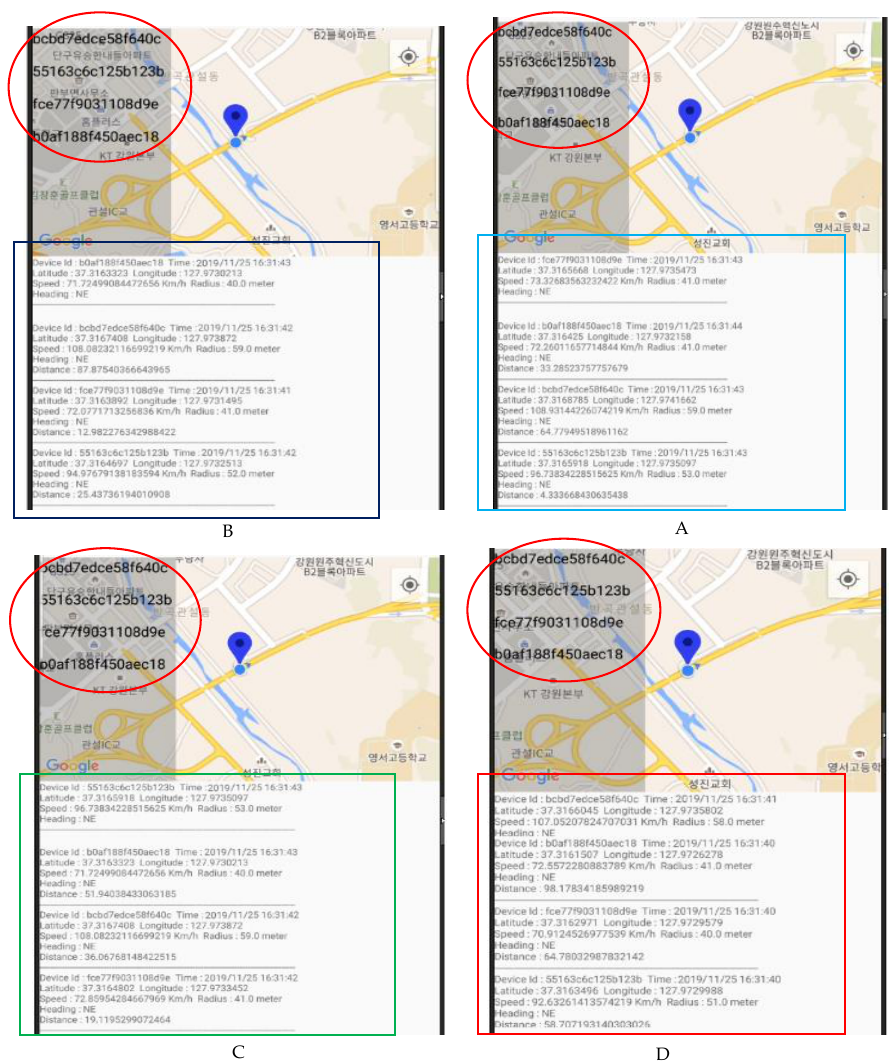
Figure 13. Images of screens when each vehicle overtakes the other.